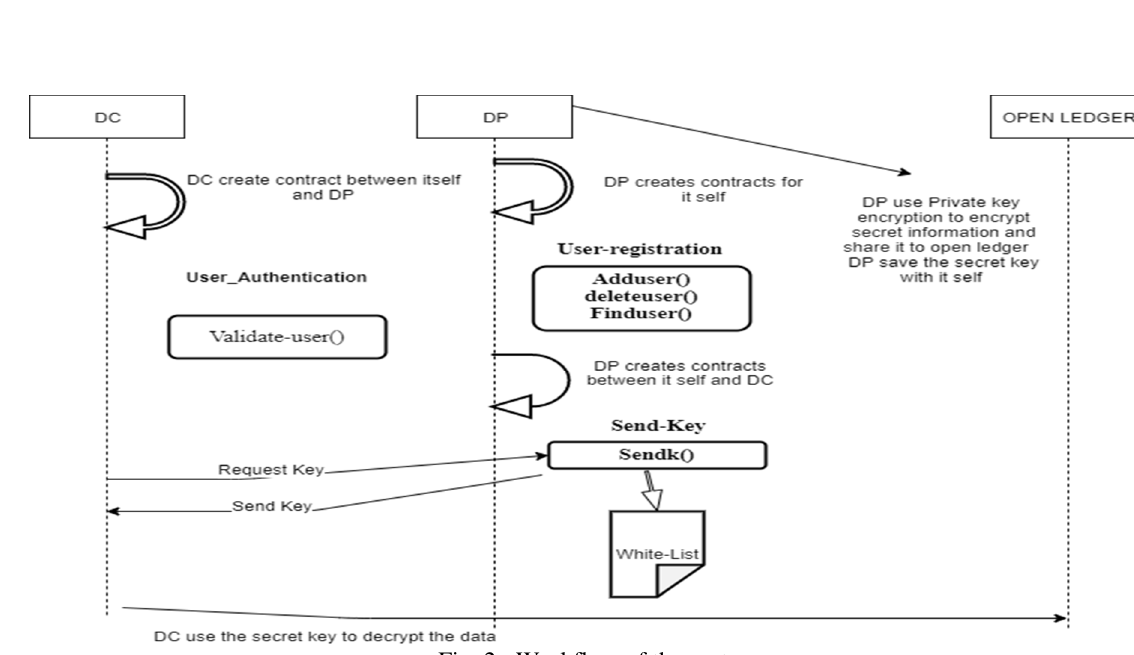
Fig. 2: Workflow of the system